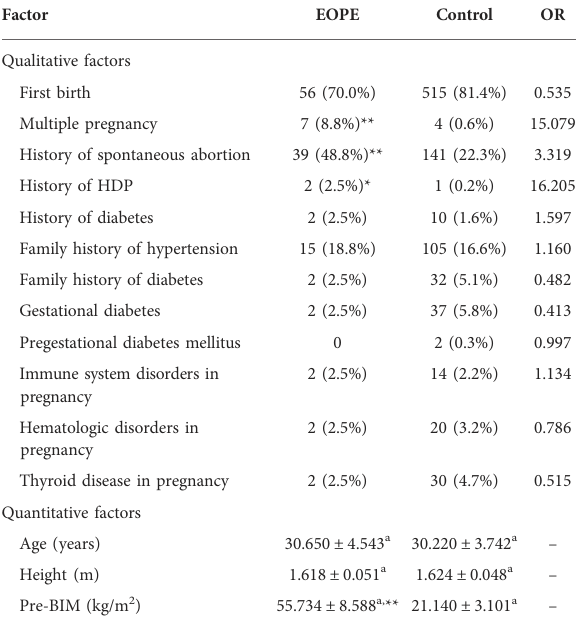
TABLE 5 Static factors analysis of early-onset